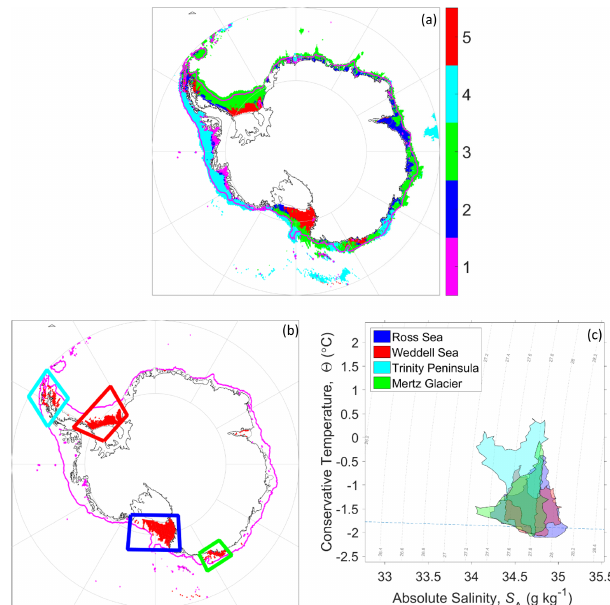
Figure 9. (a) WOA-based groups on the entire ACSS (same color code as Fig. 3e). (b) Four places are identified as HSSW regimes with the following color coding: blue is the southwestern Ross Sea, red is the Weddell Sea near the Filchner–Ronne Ice Shelf and the George V Coast, cyan is the Bransfield Strait and south of Trinity Peninsula, and green is the Mertz Glacier tongue. (c) T – S proper- ties of group 5 (HSSW) regions, with their geographic location and color code matched in (b)